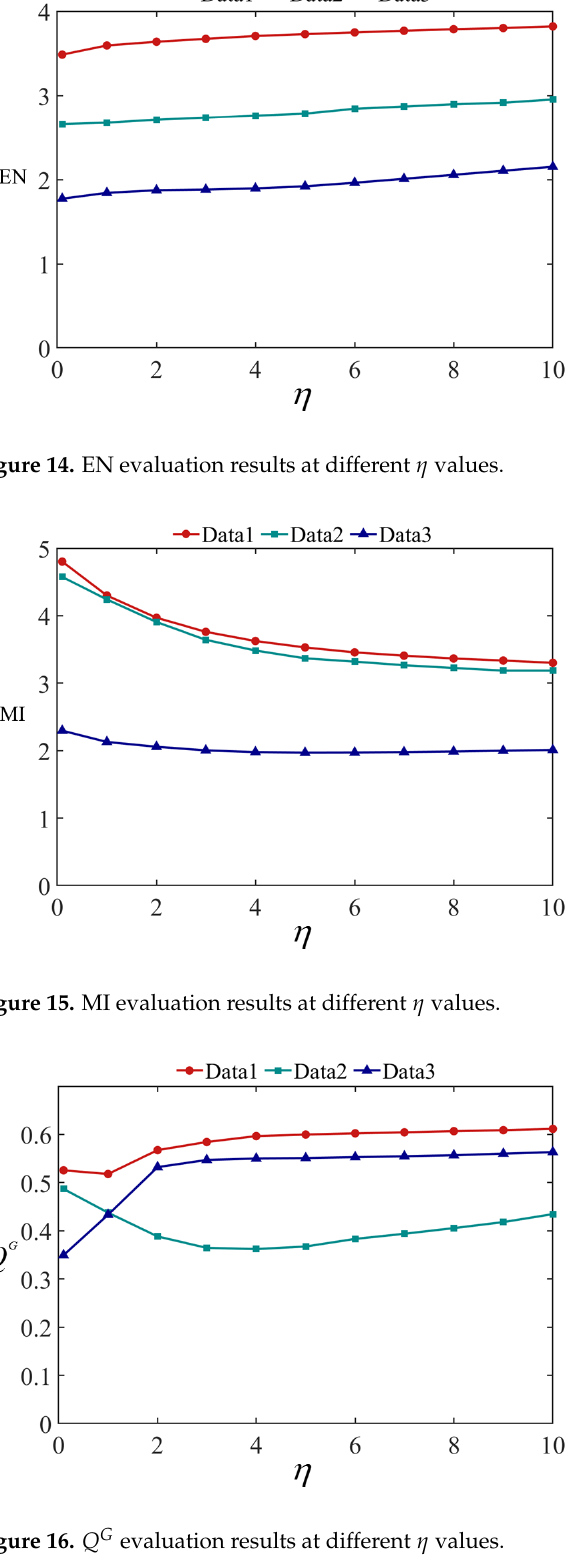
Figure 16. Q G evaluation results at different η